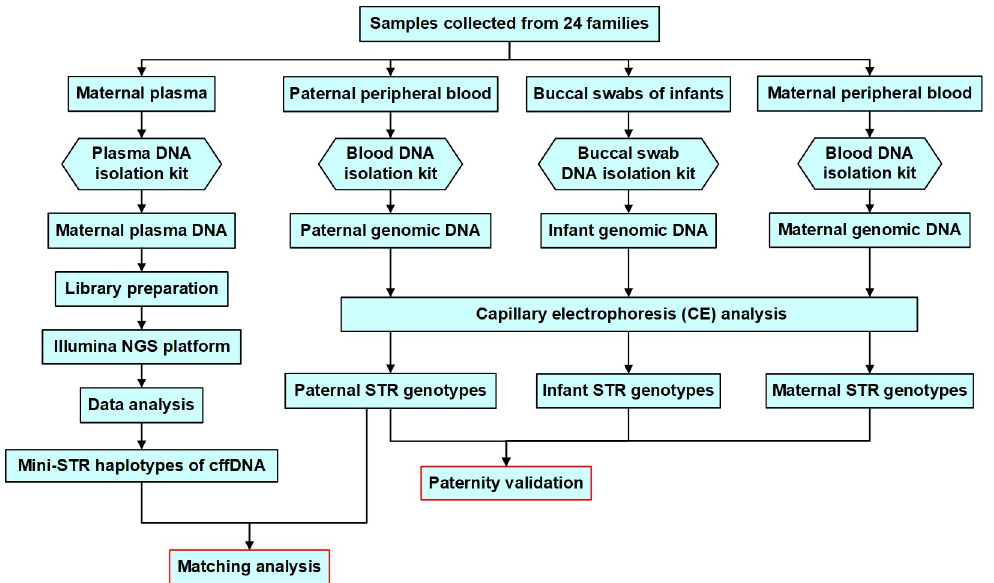
Fig 2. Flow chart for experimental procedures and data